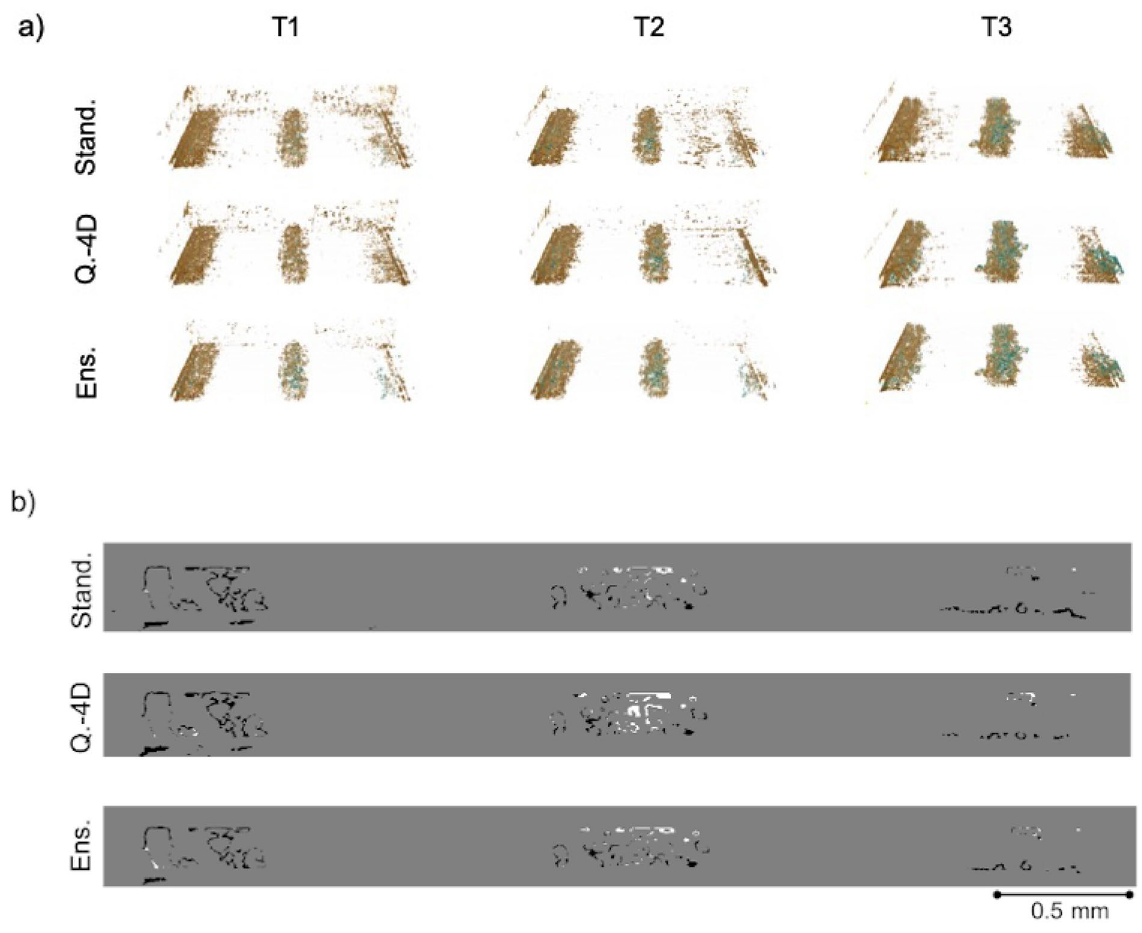
Figure 5. Comparison of the recovered water for the PEFC_3 dataset. The first column presents the time step 25 (T1), the second column time step 37 (T2) and the third column time step 49 (T3). ( a ) Difference volumes between the manual segmentation (ground truth) and SIRT-FBP-MS-D-DIFF water classifications with standard (Stand.), quasi-4D (Q.-4D) and ensemble (Ens.) training schemes of the MS-D network, respectively. The green color corresponds to features present only in the ground truth, orange to features present only in the SIRT-FBP-MS-D-DIFF water classifications. ( b ) Difference slice (slice 553, T3) between the water classification with the networks and ground truth segmentation. The white structures correspond to features present only in the ground truth segmentation, black structures only in the SIRT-FBP-MS-D-DIFF water